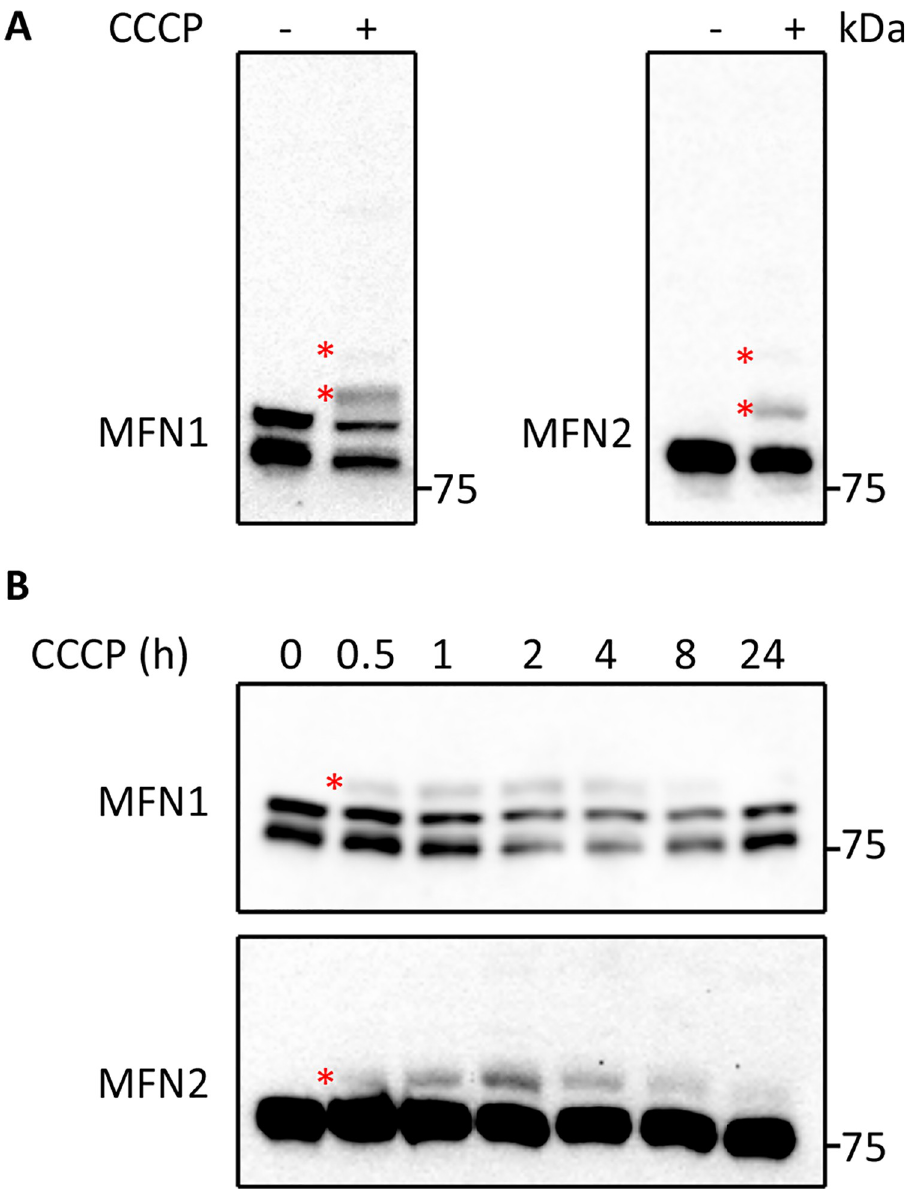
Fig 2. Analysis of CCCP-induced MFN ubiquitination in Jurkat cells. (A) Jurkat cells left untreated or treated for 2 hours with 20 μ M CCCP were analysed by western blotting with antibodies against MFN1 and MFN2. (B) Western blot analysis of Jurkat cells treated with CCCP for increasing periods of time (0.5–24 hours), developed with antibodies against MFN1 and MFN2. Asterisks indicate bands representing ubiquitinated MFN proteins.